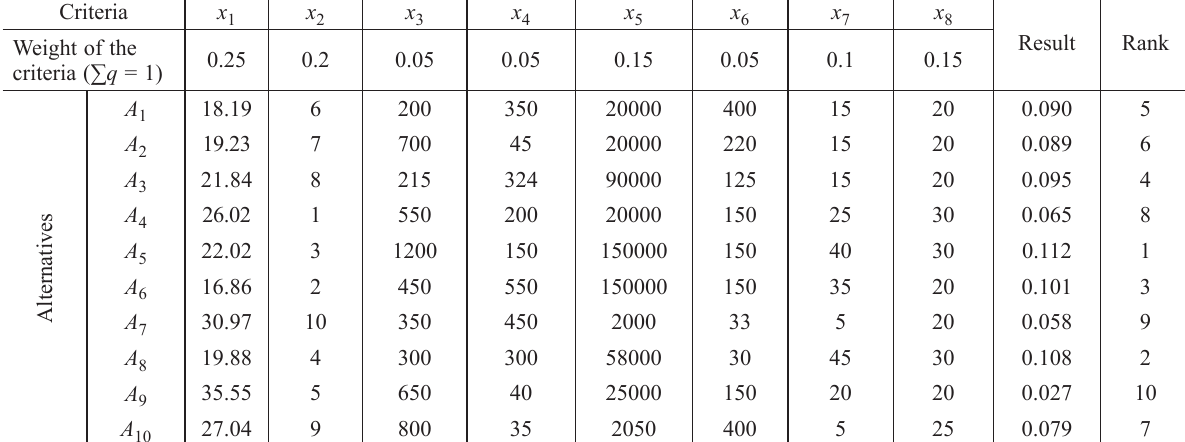
Table 5. The decision matrix of the final data obtained following the Laplace rule Criteria x 1